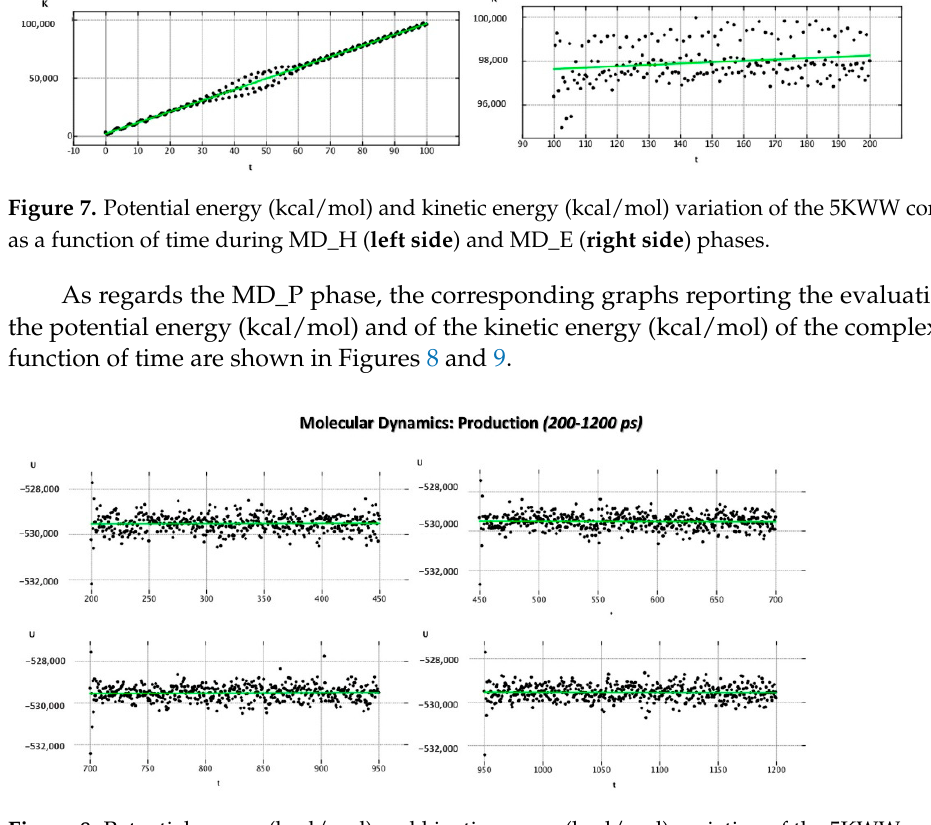
Figure 9. Potential energy (kcal/mol) and kinetic energy (kcal/mol) variation of the 5KWW complex as function of time during MD_P (1200–2200 ps) phase. According to our results, the MD_P phase was developed under stable values of po- tential and kinetic energies, leading to maintained interactions with the key residue F488 and revealing a further halogen contact between the Cl atom of JNJ-53718678 and the side chain of K498 (see Figure 10). Interestingly, these preliminary data pave the way for the following design of new F protein targeting inhibitors and support the optimization of the in-house series of benzimidazoles as anti-RSV agents. Indeed, the most promising of them (see Table S1) exhibited electron-rich atoms such as halogens at the same position of the benzimidazole ring.